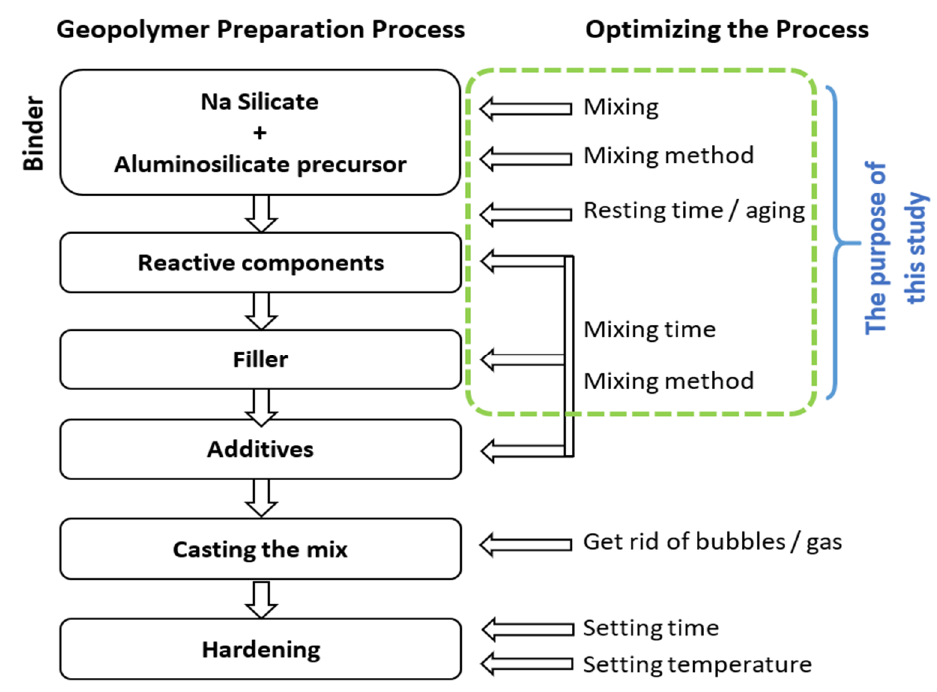
Figure 1. The geopolymer preparation process. Adapted from [5].